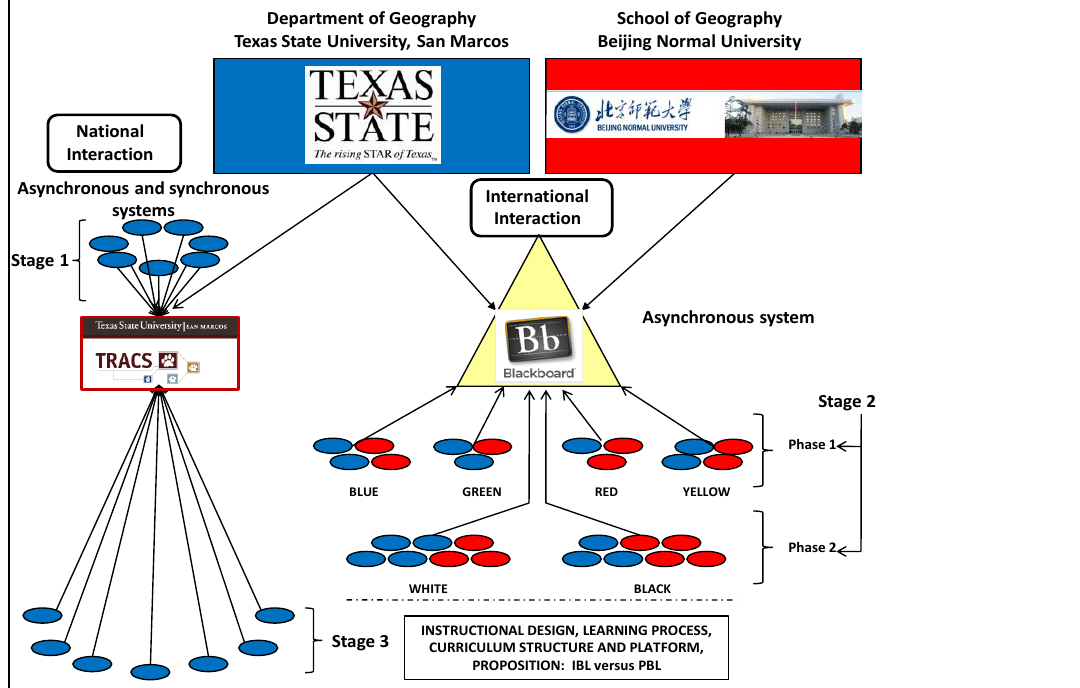
Figure 3 . The setting of the online national and international